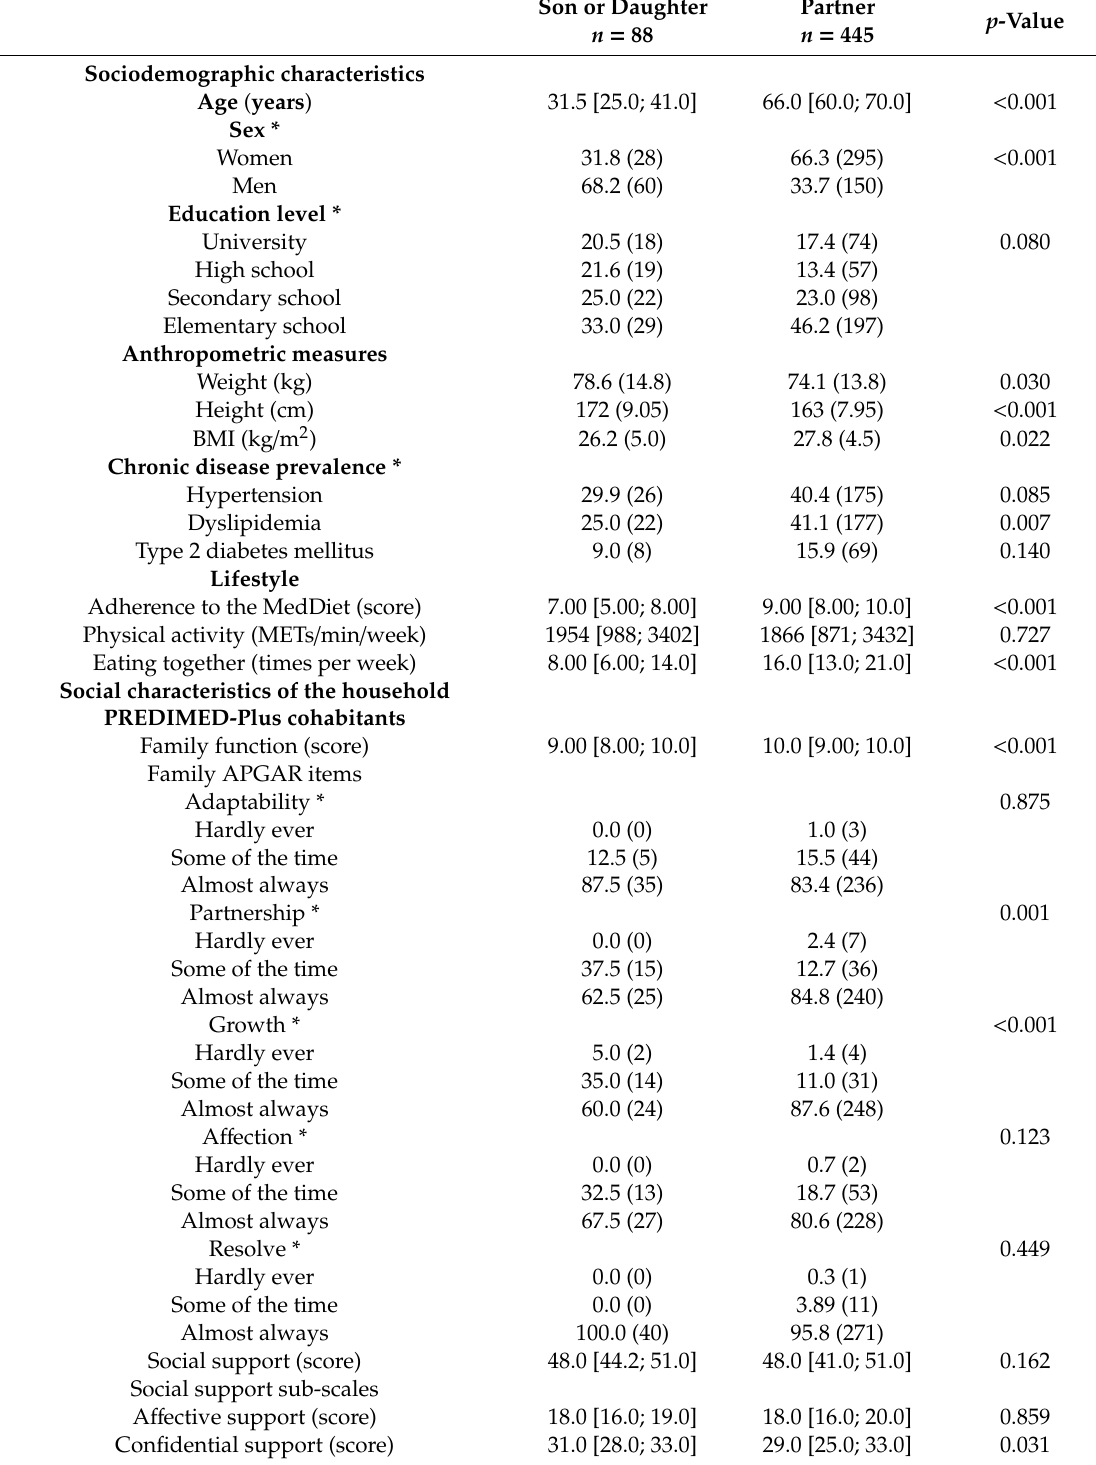
Table 1. General characteristics of the household PREDIMED-Plus